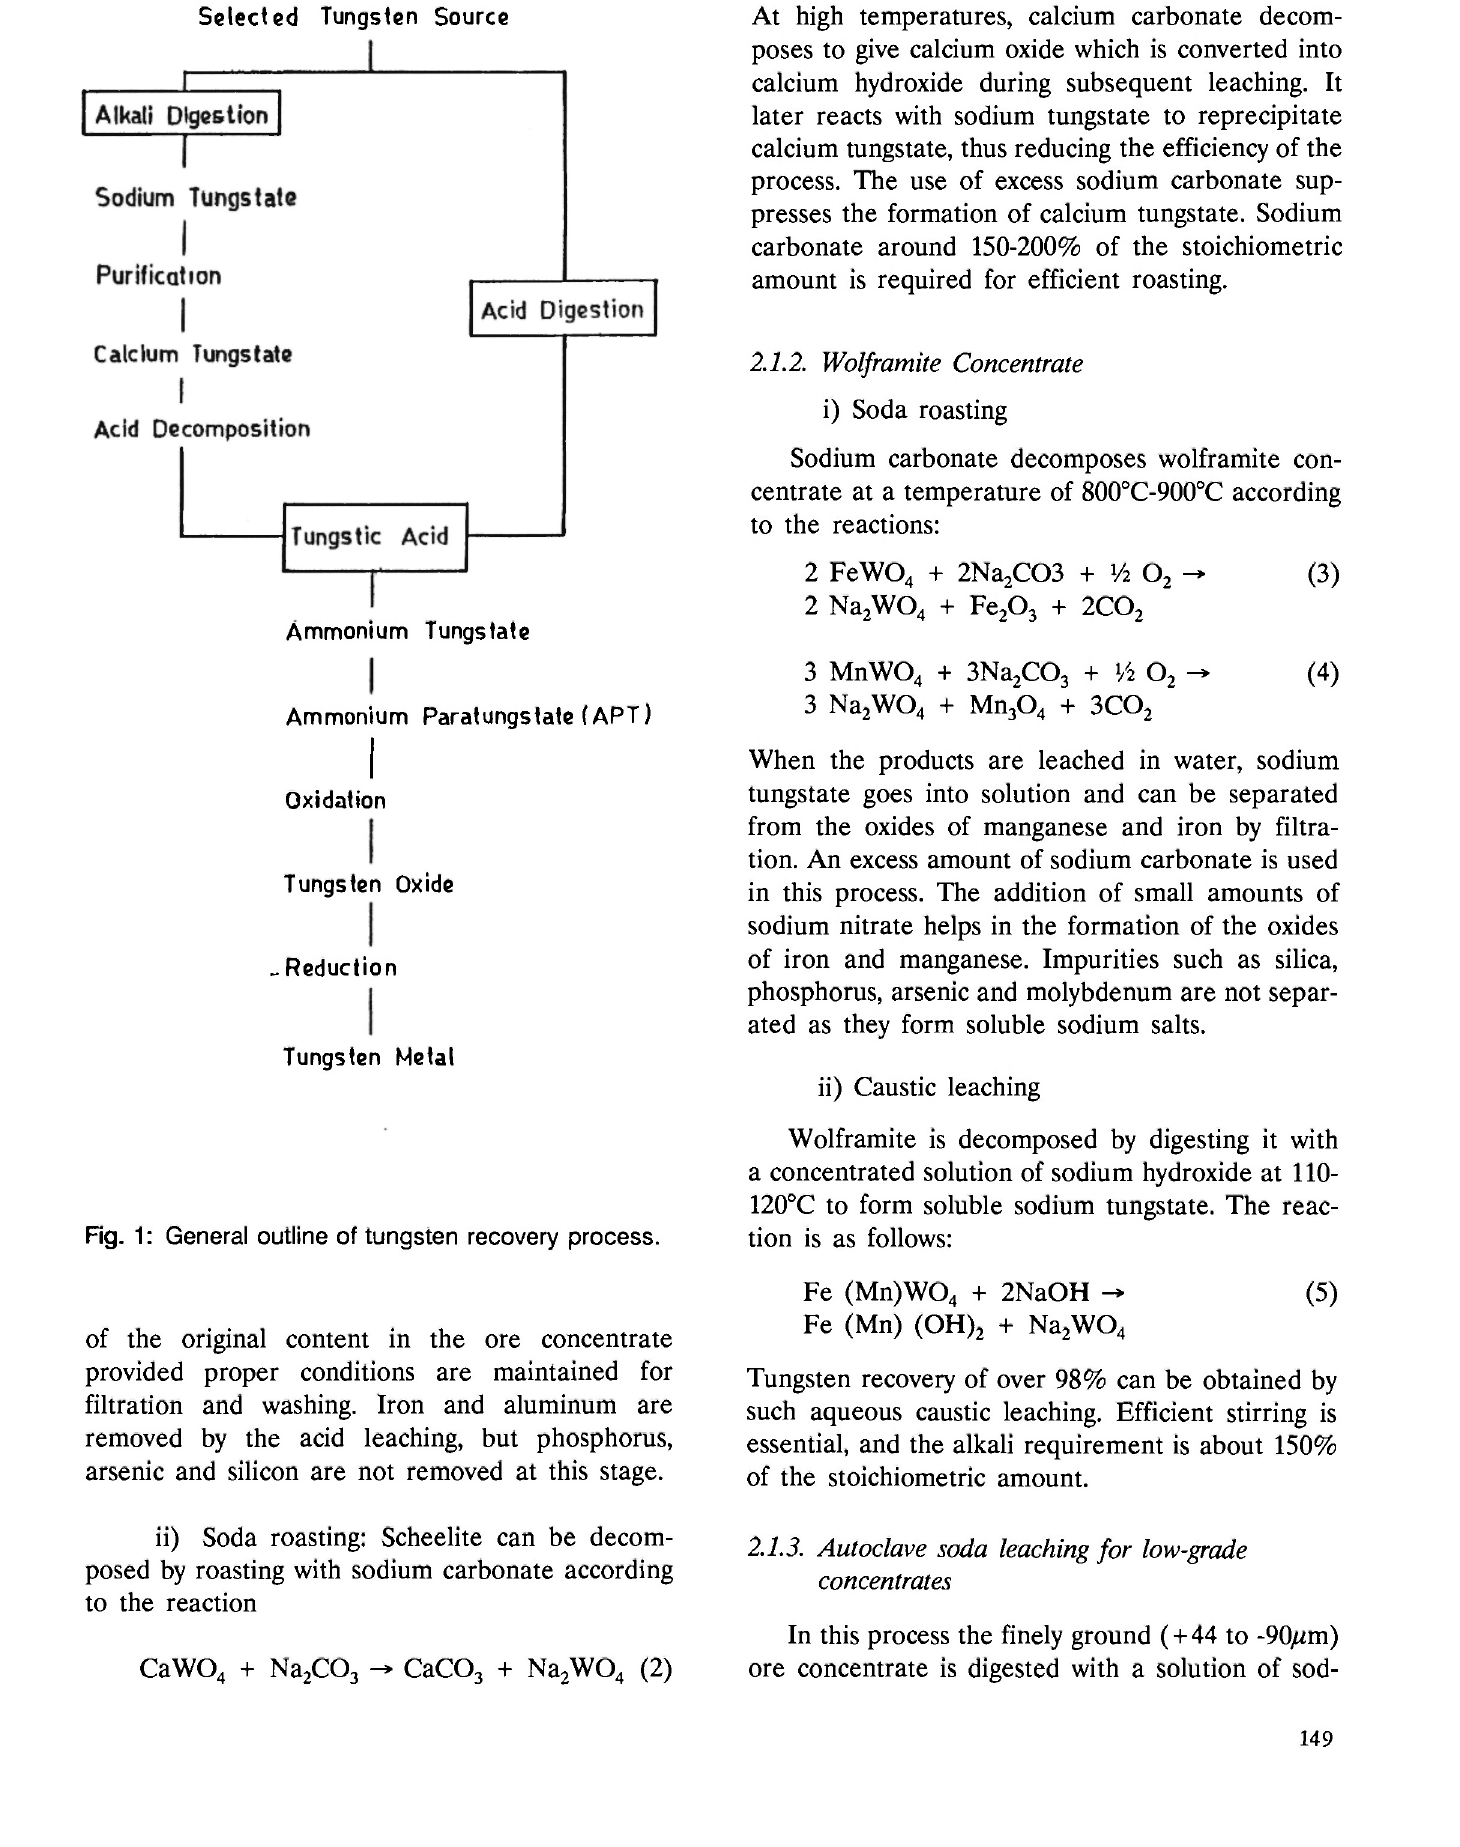
of the original content in the ore concentrate provided proper conditions are maintained for filtration and washing. Iron and aluminum are removed by the acid leaching, but phosphorus, arsenic and silicon are not removed at this